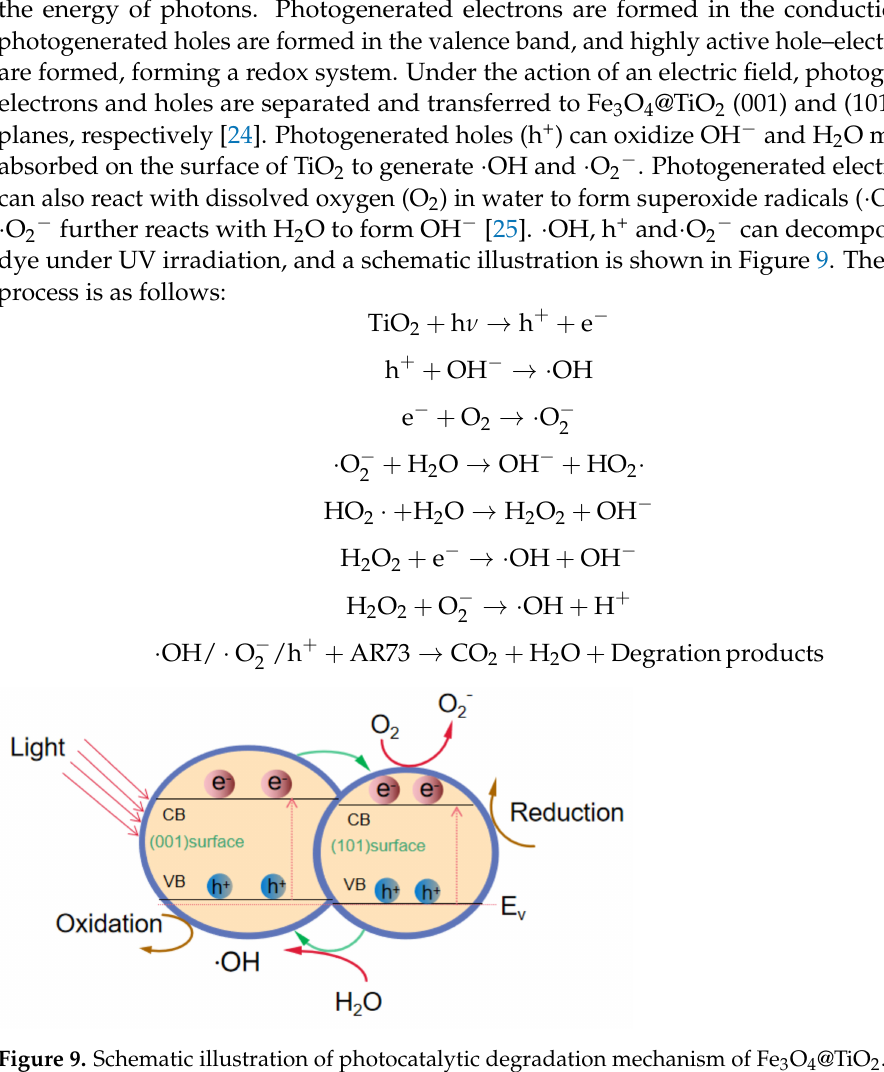
Figure 9. Schematic illustration of photocatalytic degradation mechanism of Fe 3 O 4 @TiO 2